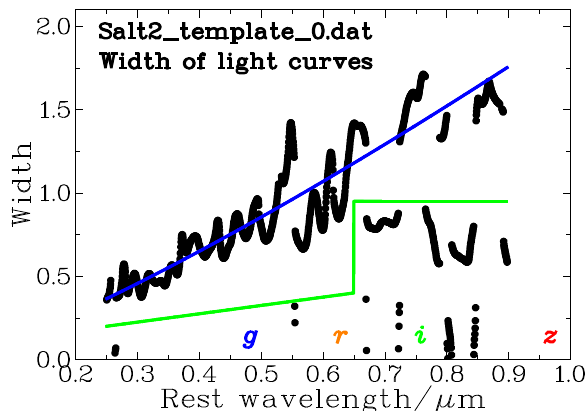
Figure 1. Plot of the relative width of the SALT2 template SNe light curves as a function of rest-frame wavelength λ shown as solid black circles. The blue line shows the fitted wavelength depen- dence equal to 1.927 λ 1.199 with λ in nm. As explained in the text only points above the green line have been used. The average rest- frame wavelength response for each filter is shown at the bottom of the figure for the griz